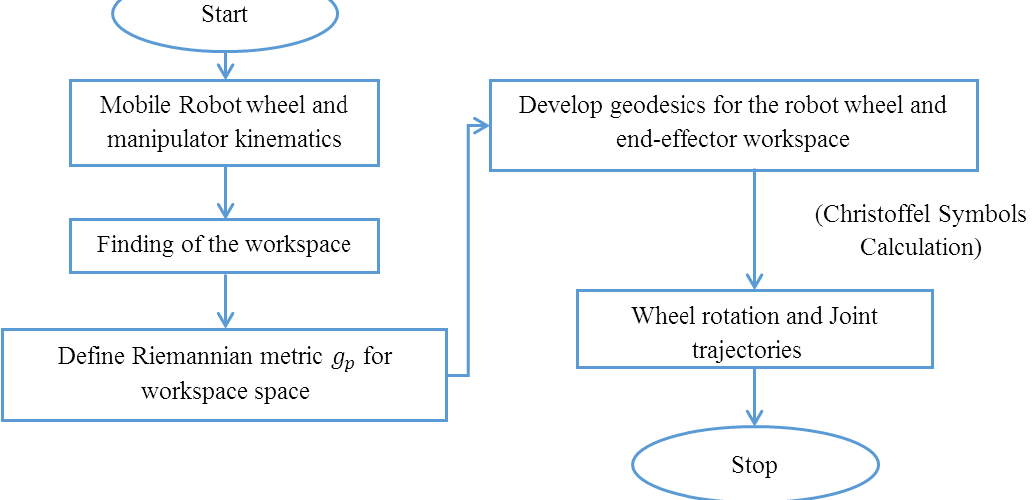
Figure 2. Flowchart showing the step by step process of mobile robot motion planning using the geodesic